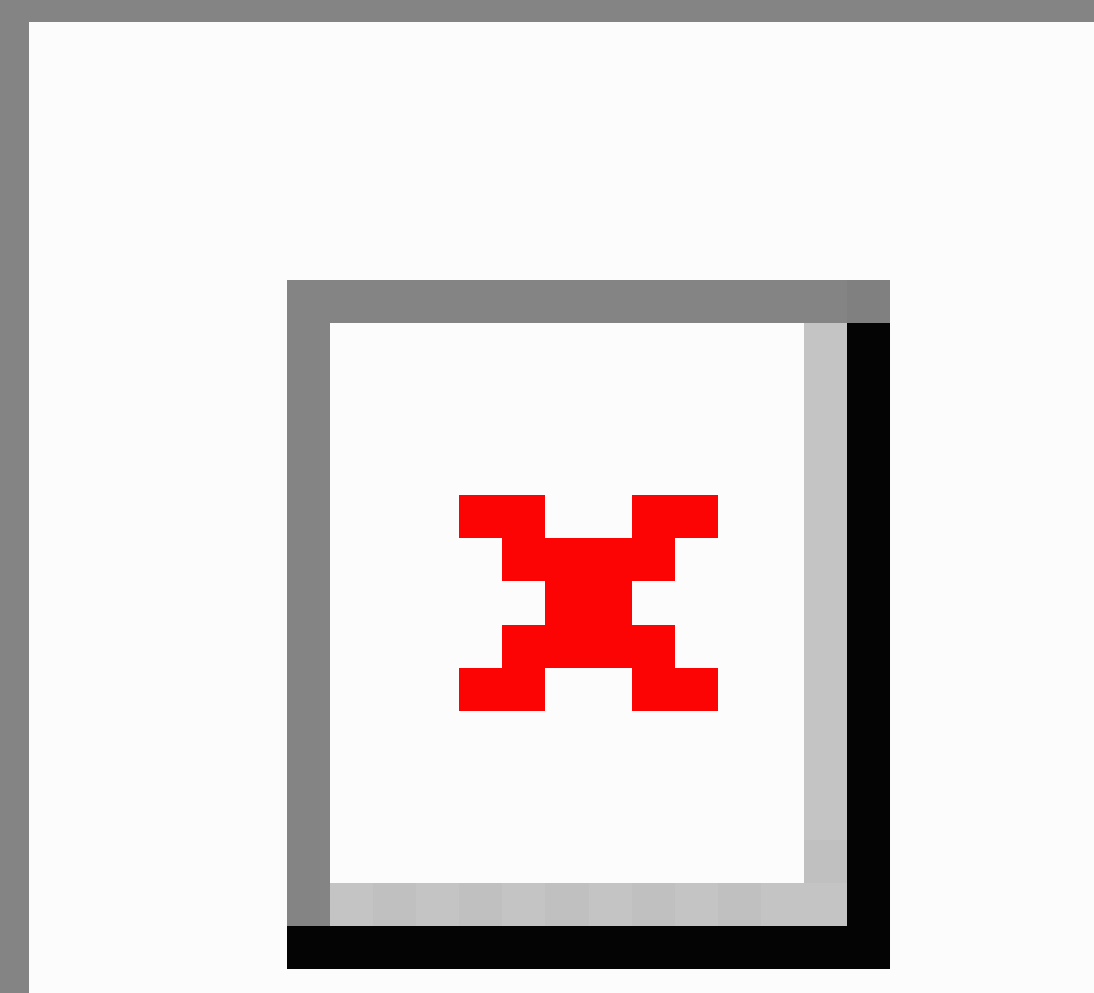
Figure 2. Number of users whose body mass index (BMI) was underweight, healthy weight, overweight, and obese at start, current, and